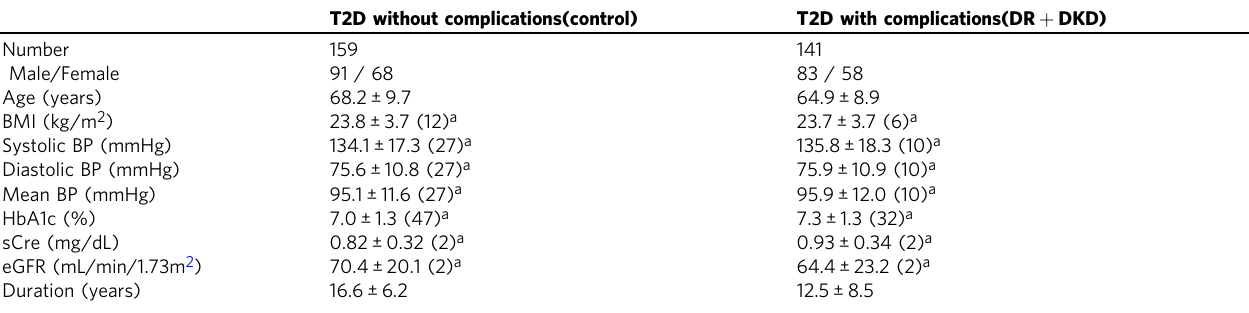
BMI body mass index, BP blood pressure, DKD diabetic kidney disease, DR diabetic retinopathy, eGFR estimated glomerular fi ltration rate, HbA1c hemoglobin A1c, sCre serum creatinine, T2D type 2 diabetes. a Numbers of participants with missing values are indicated in